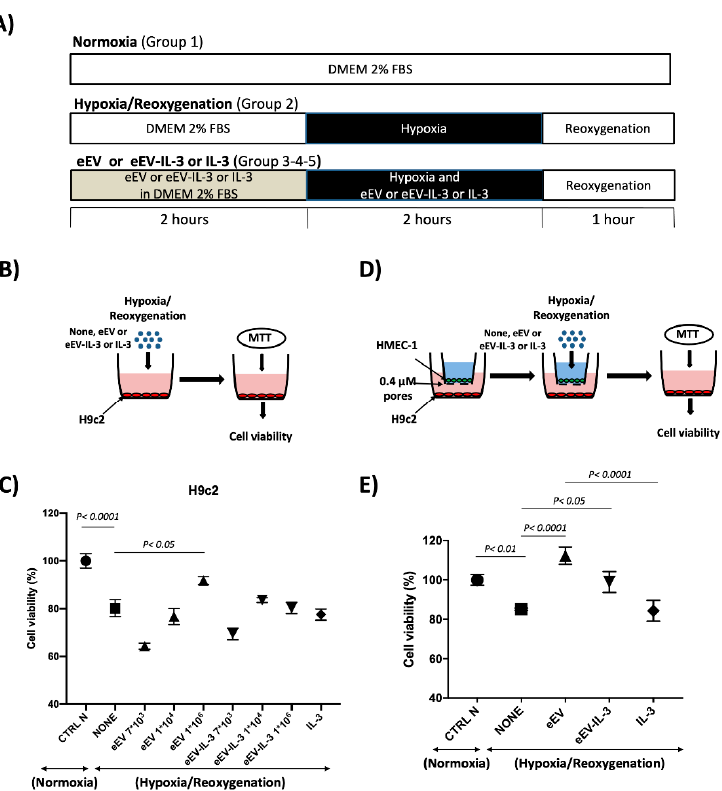
Figure 2. eEV, unlike eEV-IL-3, directly protect H9c2 cells from hypoxia/reoxygenation (H/R) injury. ( A ) Timeline of the in vitro protocol. Protocols of hypoxia (black boxes) and reoxygenation (white boxes) of H9c2 cells and EC. eEV-IL-3, eEV, or IL-3 were given for 2 h before hypoxia and during hypoxia. Cells were subjected to reoxygenation for 1 h. ( B ) Representative image of H9c2 cell treatment. ( C ) Cell viability of H9c2 cells exposed to normoxia (N) and hypoxia/reoxygenation (H/R) conditions in the presence of the indicated number of eEV and eEV-IL-3/cell. Data are presented as percentage variation with respect to mean value of cell count in normoxia (CTRL N) ( n = 3). p < 0.0001 CTRL N vs. NONE; p < 0.05 NONE vs. eEV 1 × 10 6 . ( D ) Representative image of trans-well assay of Human Microvascular Endothelial Cell Line-1 (HMEC-1) cells seeded in the upper well and H9c2 cells in the lower well. HMEC-1 cells treated or not with eEV or eEV-IL-3 were subjected to H/R conditions. 3-(4,5-Dimethylthiazol-2-yl)-2,5-diphenyltetrazolium bromide (MTT) assay was performed on H9c2 cells. ( E ) Cell viability of H9c2 cells exposed to H/R conditions ( n = 4). p < 0.01 CTRL N vs. NONE and eEV; p < 0.0001 NONE vs. eEV and eEV vs. IL-3. Data were normalized to the mean value of normoxic control (CTRL N).